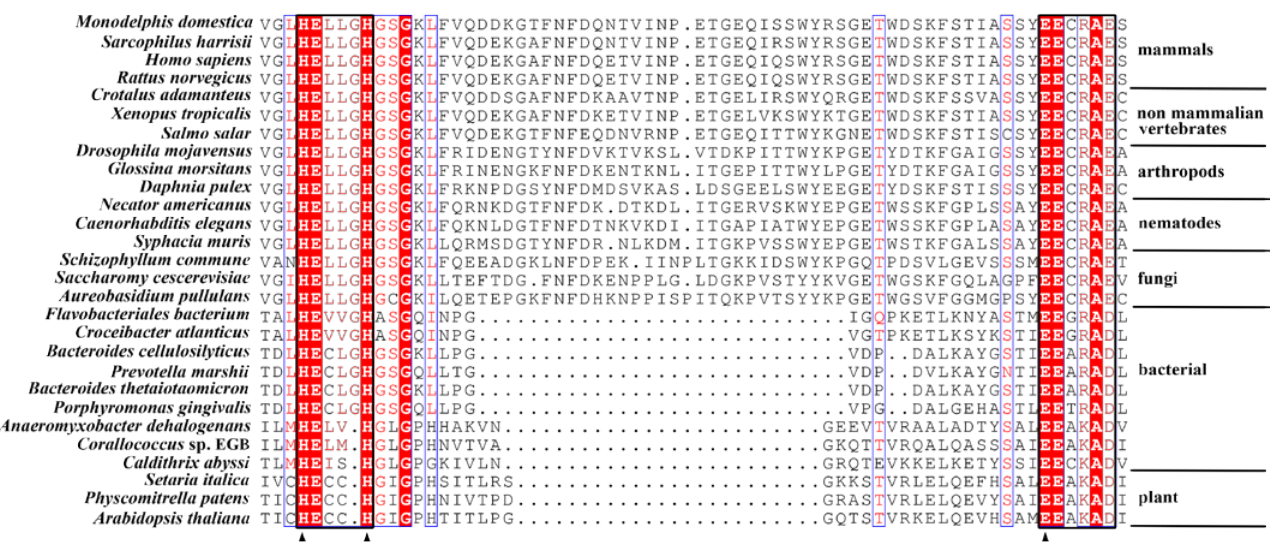
are marked by rectangular boxes. The triangles show the amino acids involved in zinc ion coordination. Dots indicate gaps. Identical amino acid residues in the same position are shaded.